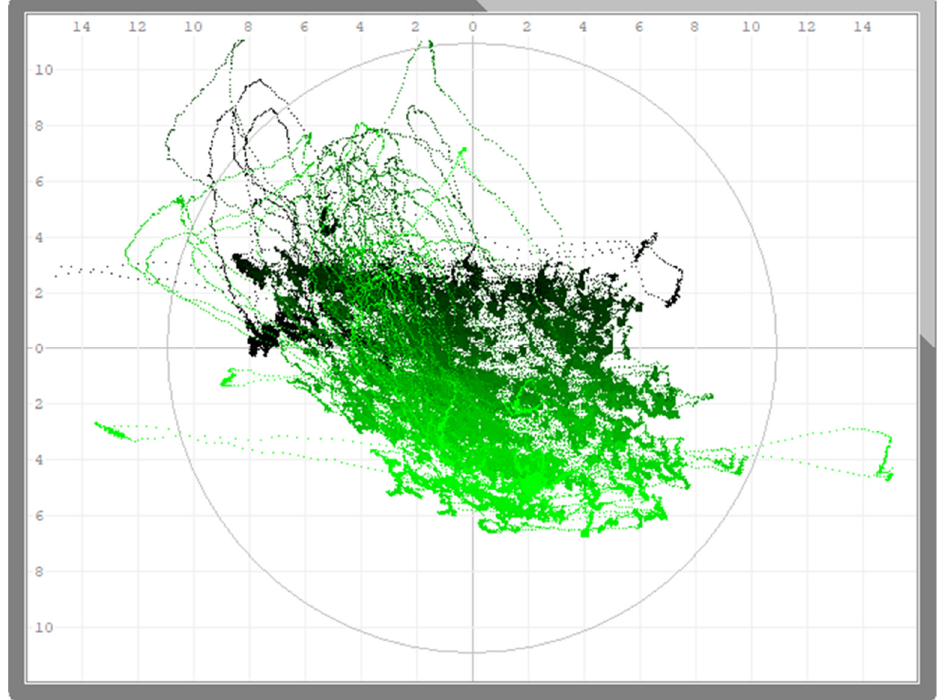
Figure 10. Working session with the main unit of the SimulationCenter application, showing the eye movements on the computer display of a participant during an entire experimental session.